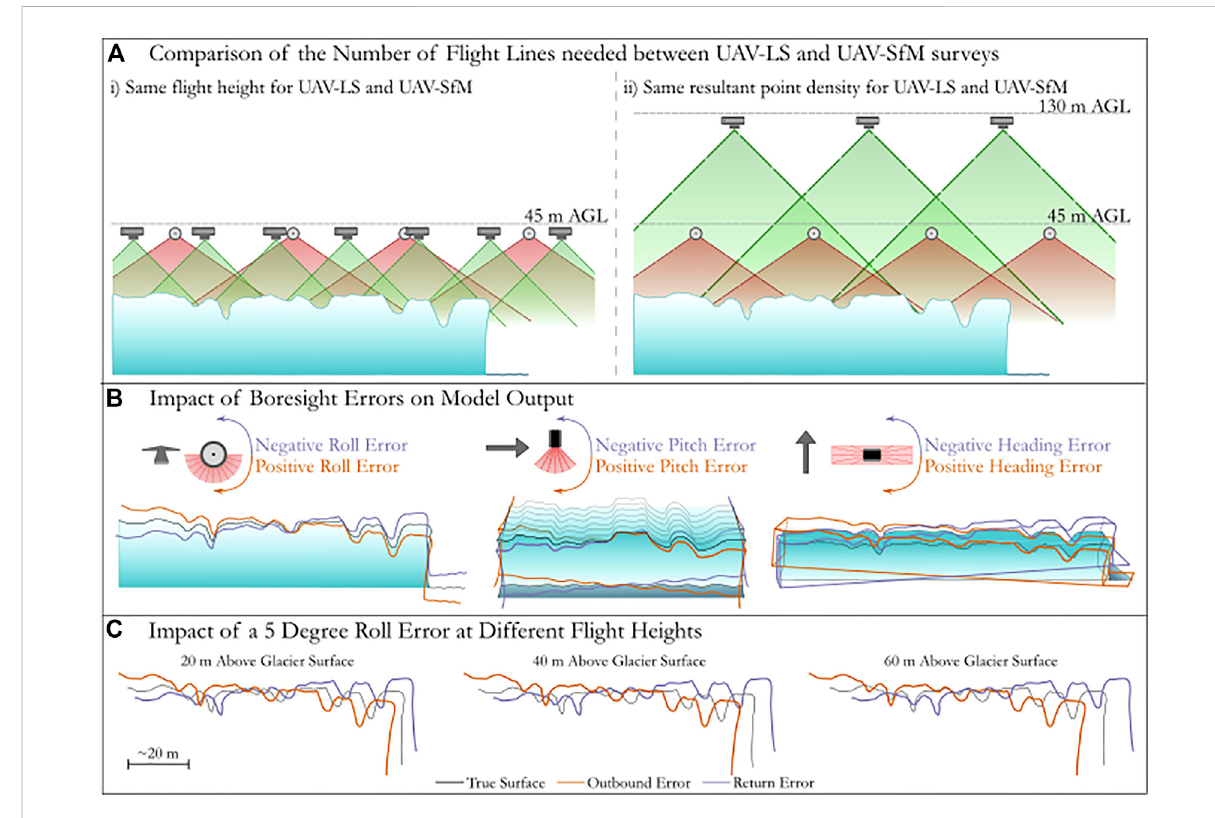
FIGURE 11 (A) The impact of different fl ight heights on the number of fl ight lines required for UAV-LS and UAV-SfM surveys. This demonstrates that when fl ying at the same height, there is a requirement for SfM surveys to have a greater number of fl ight lines for a given area, but that the resultant point density will be greater. Conversely, for a similar point density from the resulting processing, UAV-SfM surveys can be fl own at a higher fl ight height which requires less fl ight lines for a given area of interest. (B) The impact of different boresight calibration errors on the resultant point cloud (these are typically the most challenging to measure accurately). Arrows show the direction of fl ight, with the scan outlines in orange and purple relating to a positive and negative roll, pitch, or heading error, respectively, in the scan coordinate system. The direction of these errors are shown around each orientation of thelaser scanner used inthis study. (C) How theerrors outlined in (B) propagate with surveyheight AGL. The true surface isoutlinedinblack,withrollrotationsof5 ° appliedatapproximately20,40,and60 m fl ightheights.Outbounderrorreferstotherollwhen fl